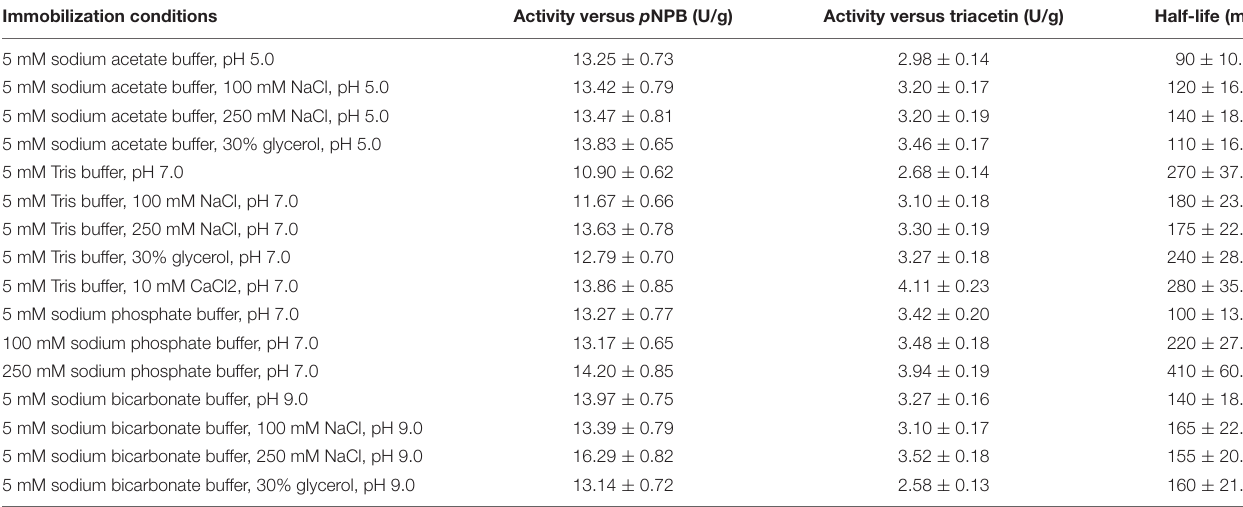
TABLE 1 | Activities versus different substrates and half-lives of different PFL biocatalysts prepared under different immobilization conditions. Immobilization